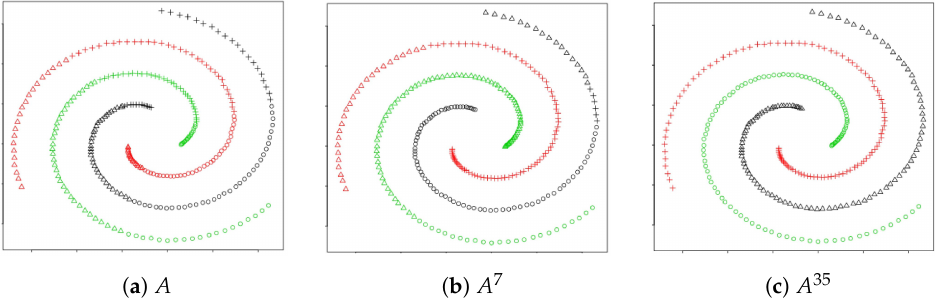
Figure 3. As we repeatedly apply the transformation discussed in Section 6, the PAM clustering algorithm correctly identifies clusters in the Spiral